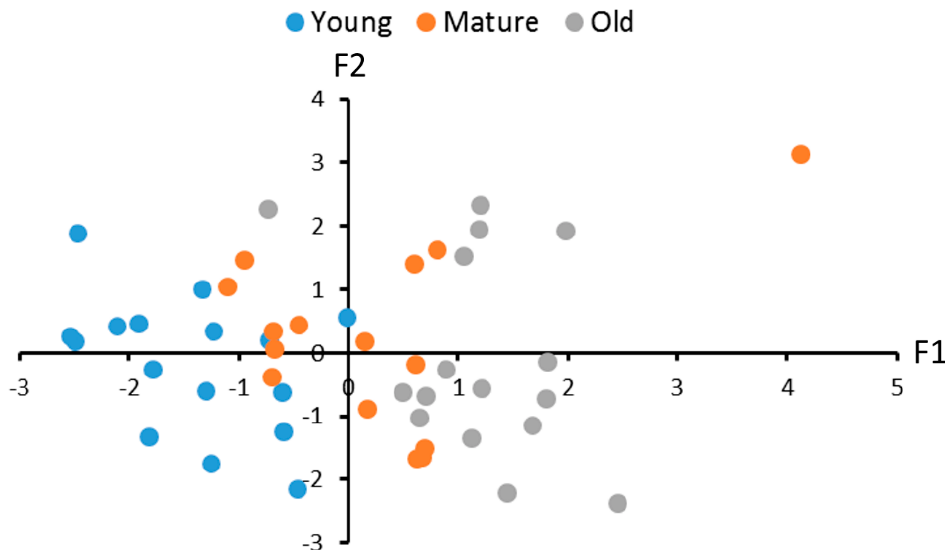
Figure 5. Individual scores for sixteen 2 (young)-month-old, fifteen 4 (mature)-month-old and sixteen 7 (old)-month-old males and females (1:1) of N. furzeri along with factor 1 and factor 2 yielded by the principal component analysis. These factors generalize the 5-HT and 5-HIAA levels, 5-HIAA/5-HT turnover rate and TPH and MAO activities in the brain. The coordinates of the two axes represent the factor scores of individual animals. All 16 scores corresponding to 2-month-old, six out of 15 scores corresponding to 4-month-old and one out of 16 scores corresponding to 7-month-old killifish are located in the left half of the graphic. Nine out of 15 scores corresponding to 4-month-old and fifteen out of 16 scores corresponding to 7-month-old killifish are located in the right half of the graphic.